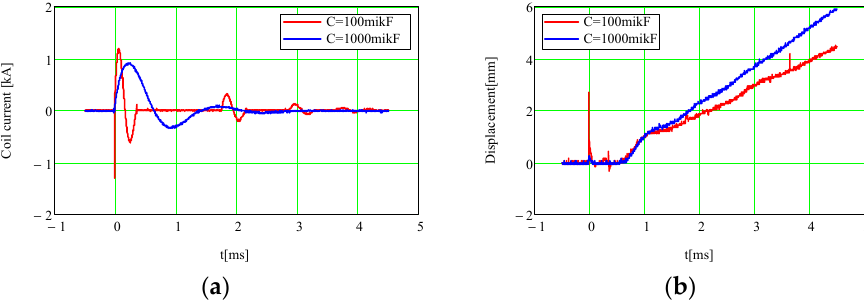
Figure 5. Registration of waveforms (at disturbed gate signal from Figure 4b) for C = 100 μ F red line, C = 1000 μ F blue line: ( a ) Coil currents ( b ) Displacements.